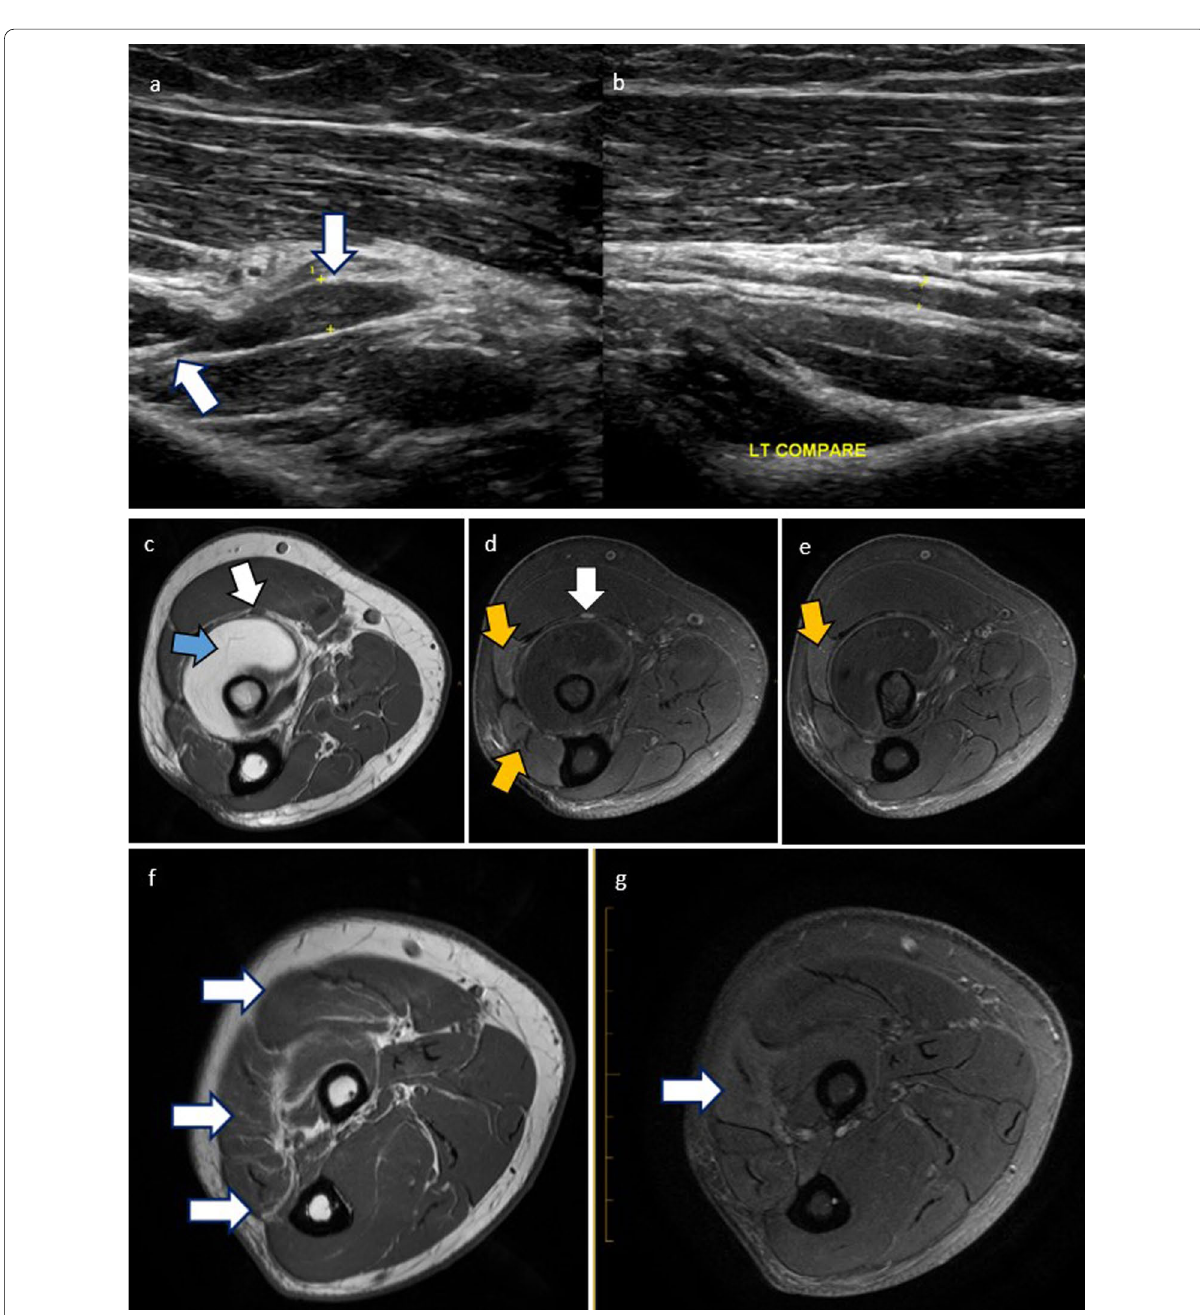
Fig. 8 Cases of posterior interosseous nerve (PIN) pathology are illustrated: a , b Forearm ultrasound of a 58-year-old female who presented with arm pain. There is focal thickening throughout the right PIN ( a , white arrows). This extends into the arcade of Frohse. This appearance can be seen with PIN syndrome. No adjacent collection or mass is identified. There was focal tenderness with transducer pressure. The left PIN is provided for comparison ( b ). c – e 60-year-old male who presented with progressive weakness of finger extension. Intramuscular lipoma of the supinator (blue arrow) resulted in PIN impingement at the arcade of Frohse ( c ). Axial T1 ( c ) and Axial PDFS images at the level of narrowing ( d ) and more distally ( e ), show focal thickening and hyperintensity of the PIN ( c , d , white arrows). There is denervation oedema and atrophy of the extensor muscles ( d , e , yellow arrows). f , g Axial PD ( f ) and PDFS ( g ) sequences with denervation oedema and atrophy of extensor muscles (white arrows) innervated by the PIN (not